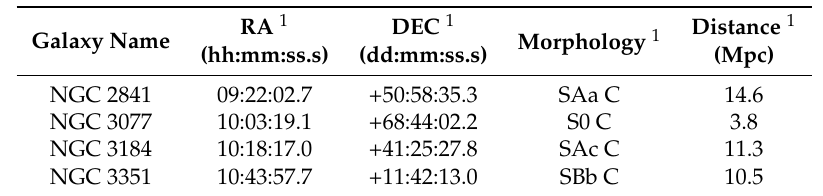
Table 1. Galaxy sample, morphology and positions.